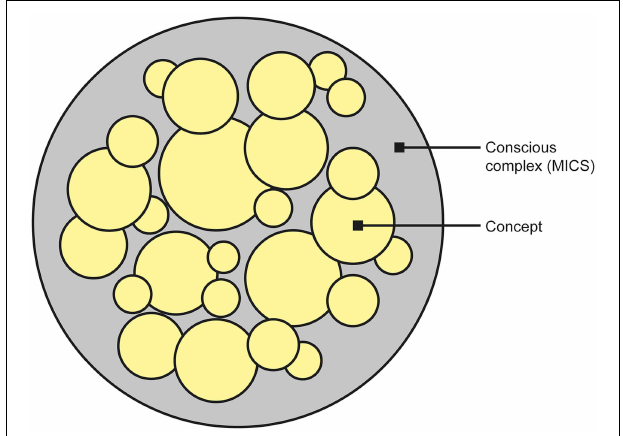
FIGURE 4 | The unified conscious complex (outer gray circle) is formed from a constellation of concepts (yellow circles). The degree to which each concept is present in the experience is quantified by ϕ (represented by the size of the circle), and the overall quantity of consciousness is quantified by 8 (represented by the size of the gray